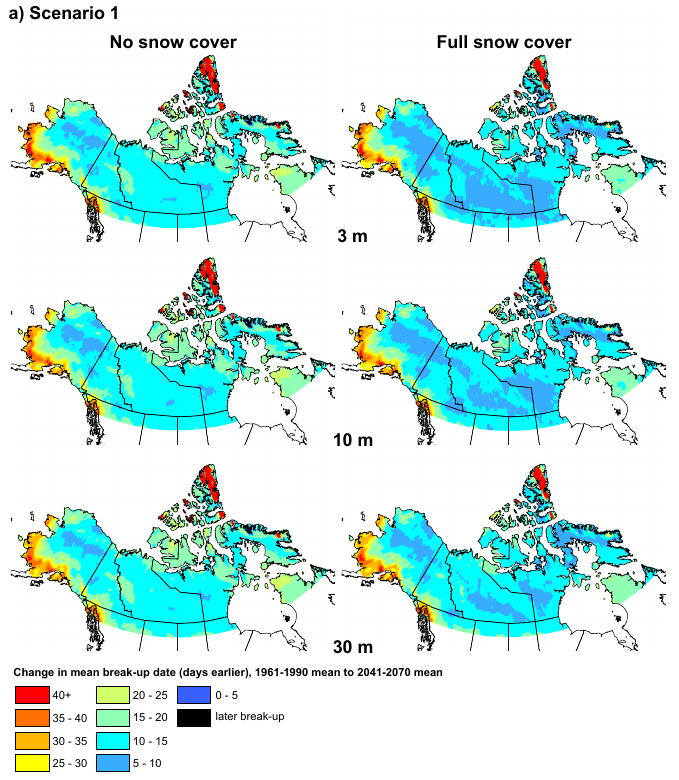
Fig. 10a. Change in mean break-up date from 1961–1990 to 2041–2070 for (a) scenario 1; (b) scenario 2; (c) the difference between the scenarios for the 2041–2070 mean break-up